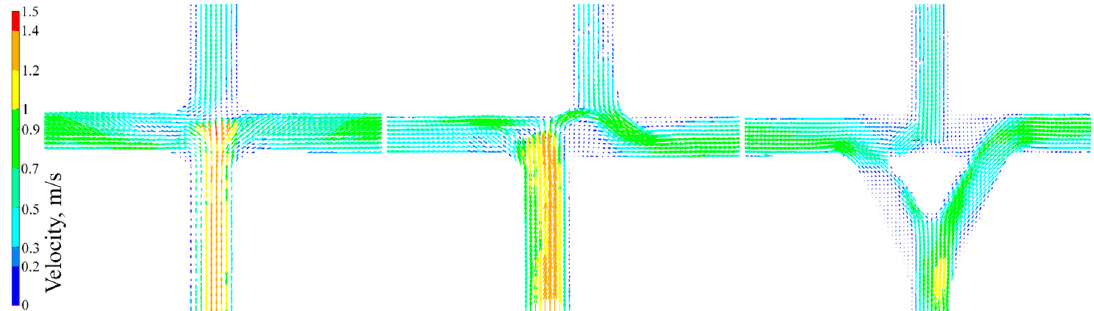
Figure 7. Distribution of the flow velocity vector field obtained by experimental data. Flow profiles are similar to CFD results. TCPC ‐ 3 has the lowest mean density of the velocity.